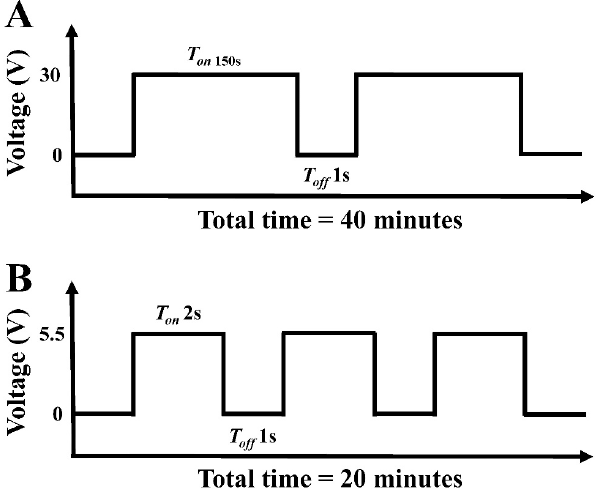
Figure 1. Schematic diagram of the pulse current used in the ( A ) anodization of titanium dioxide nanotubes and ( B ) electrodeposition of cobalt ‐ substituted hydroxyapatite.